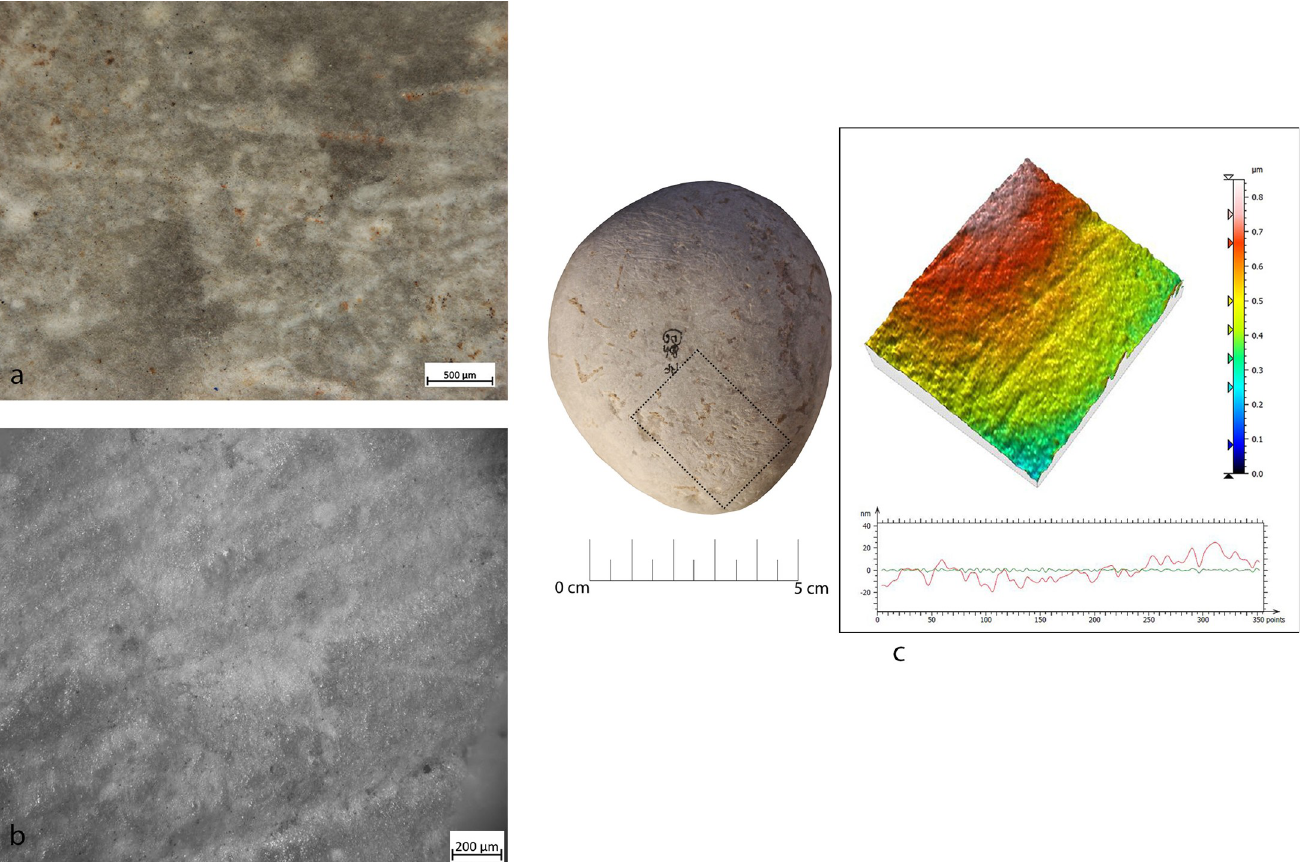
Fig 25. Use wear identified on artefact RF80. (a) Macro-traces (20x), small circular pits associated with long parallel striations, located in apical top with oblique orientation; (b) micro-traces (200x), polishing is absent, a general rounding of the artefact can be observed; (c) 3D microtopography of the used